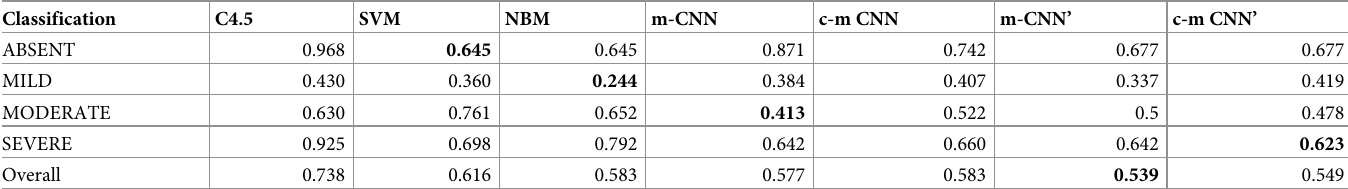
Table 5. Results on the CEGS N-GRID 2016 test set. The CNN Models with Dropout are Denoted with an Apostrophe. Classification